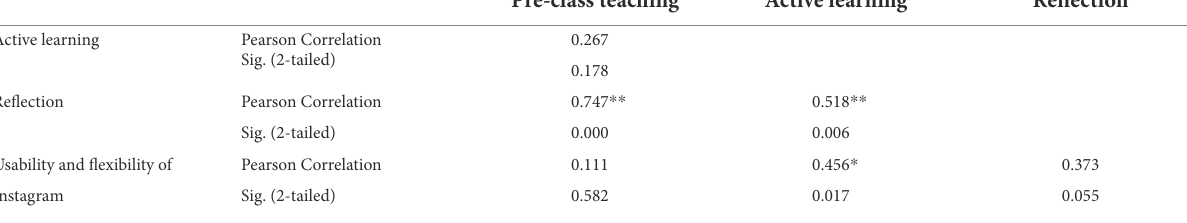
TABLE 7 Correlations among the categories of the